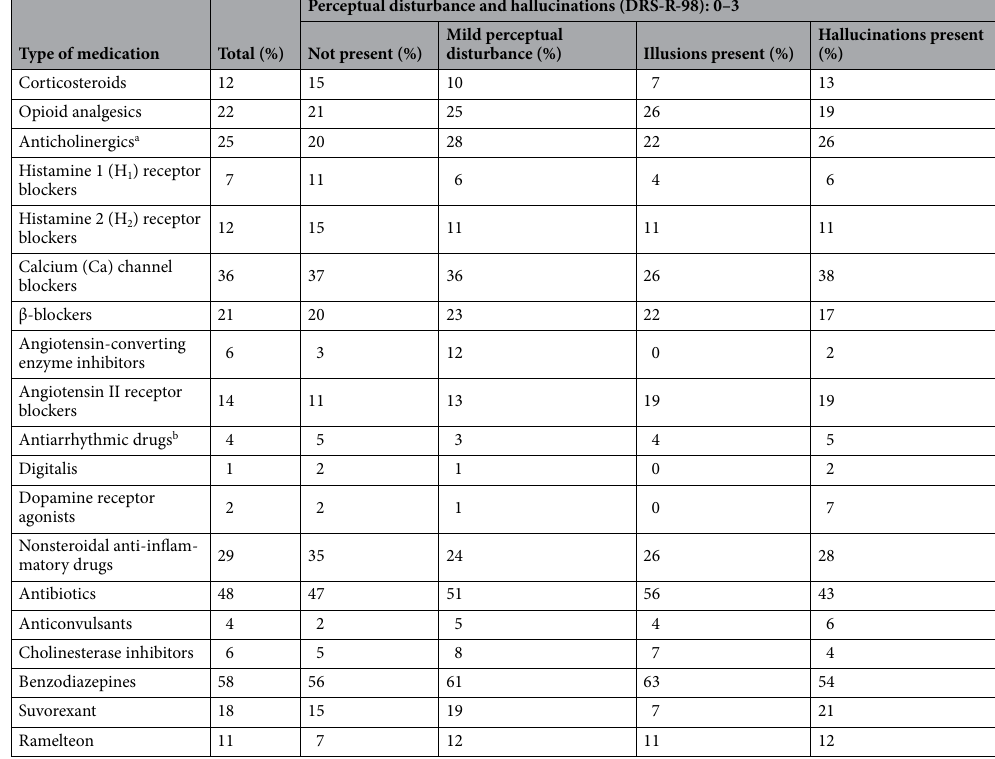
Table 2. Prescribed medications in patients with delirium. a Compounds that have anticholinergic activity, such as H1 blockers, H2 blockers, and dopamine receptor agonists, are not included in the "anticholinergics". b Compounds that have antiarrhythmic activity, such as b-blockers and calcium channel blockers, are not included in the "antiarrhythmic drugs".